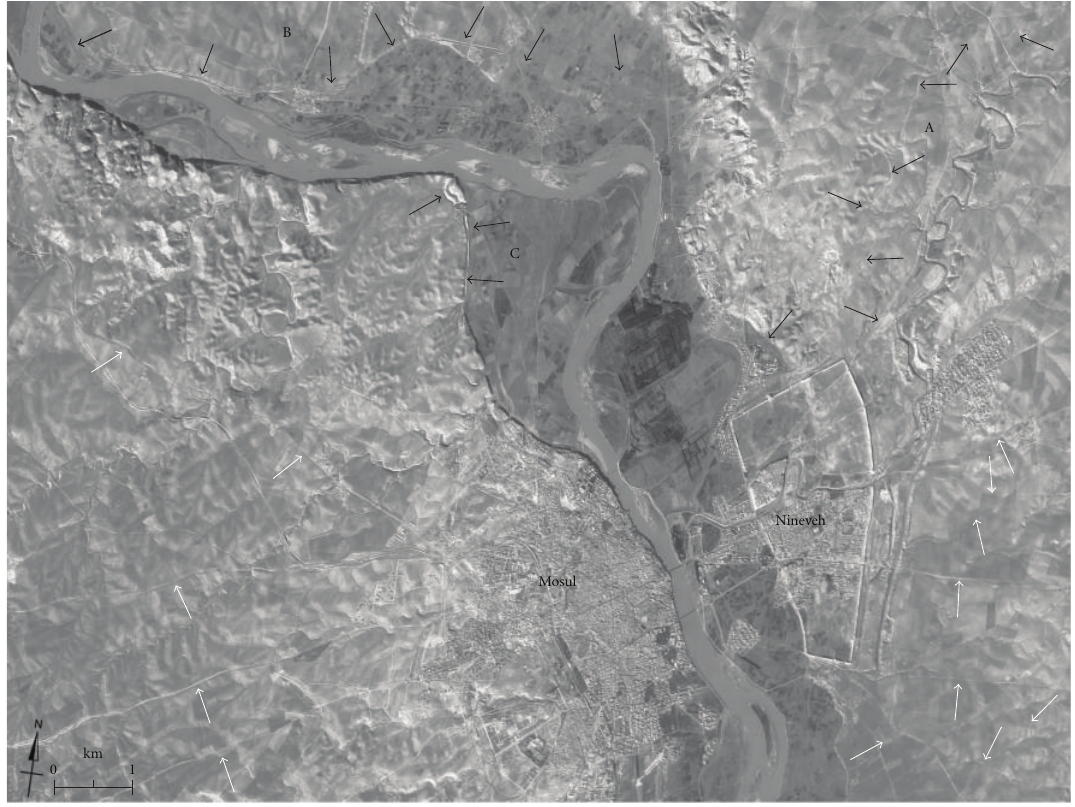
Figure 16: The territory of Nineveh in a Corona KH-4B photo of 1967: black arrows show traces and remains of ancient canals ((A) Kisiri canal; (B) Tarbisu canal) and modern waterworks (C), while white arrows point traces and remains of ancient roads.